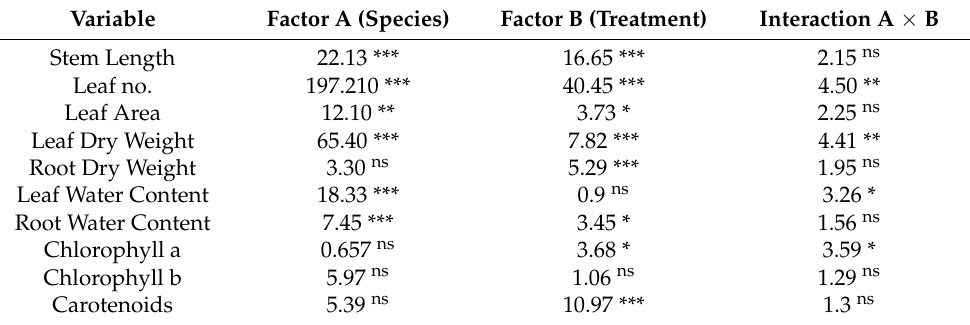
Table 1. Factorial ANOVA (F values) considering the effect of Species (A) and Treatment (B) and their interaction (A × B) on growth parameters and photosynthetic pigments in Amaranthus albus and A. hybridus . Asterisks indicate the degree of significance: * p < 0.05, ** p < 0.01; *** p < 0.001, ns = not significant. Variable